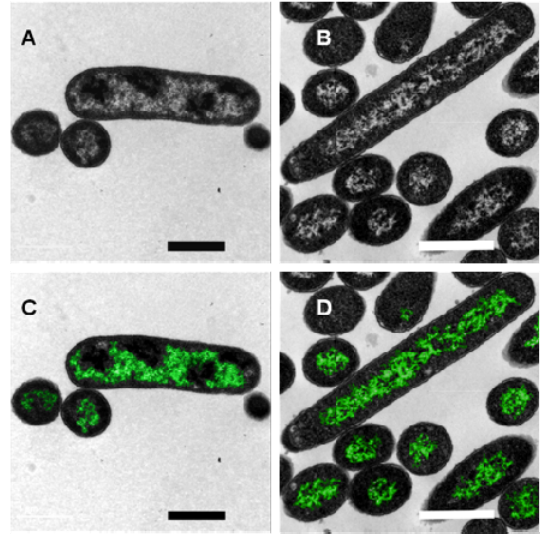
Figure 7. Transmission electronic microscopy images of E. coli. ( A , C ) Cells that over-expressed HCcp3; ( B , D ) Control cells without HCcp3 expression; ( C , D ) The false green color represents the nucleoid distribution in the cells. Scale bar: 1